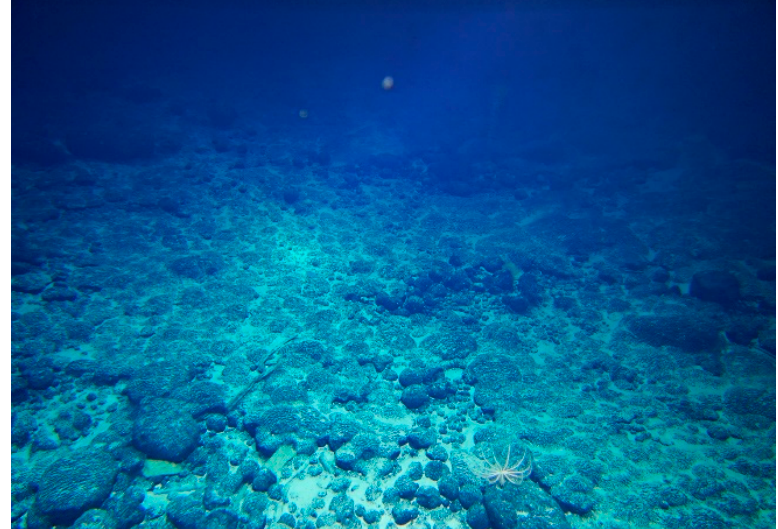
Figure 8. The real scene of the CRCs undersea captured by the underwater camera.